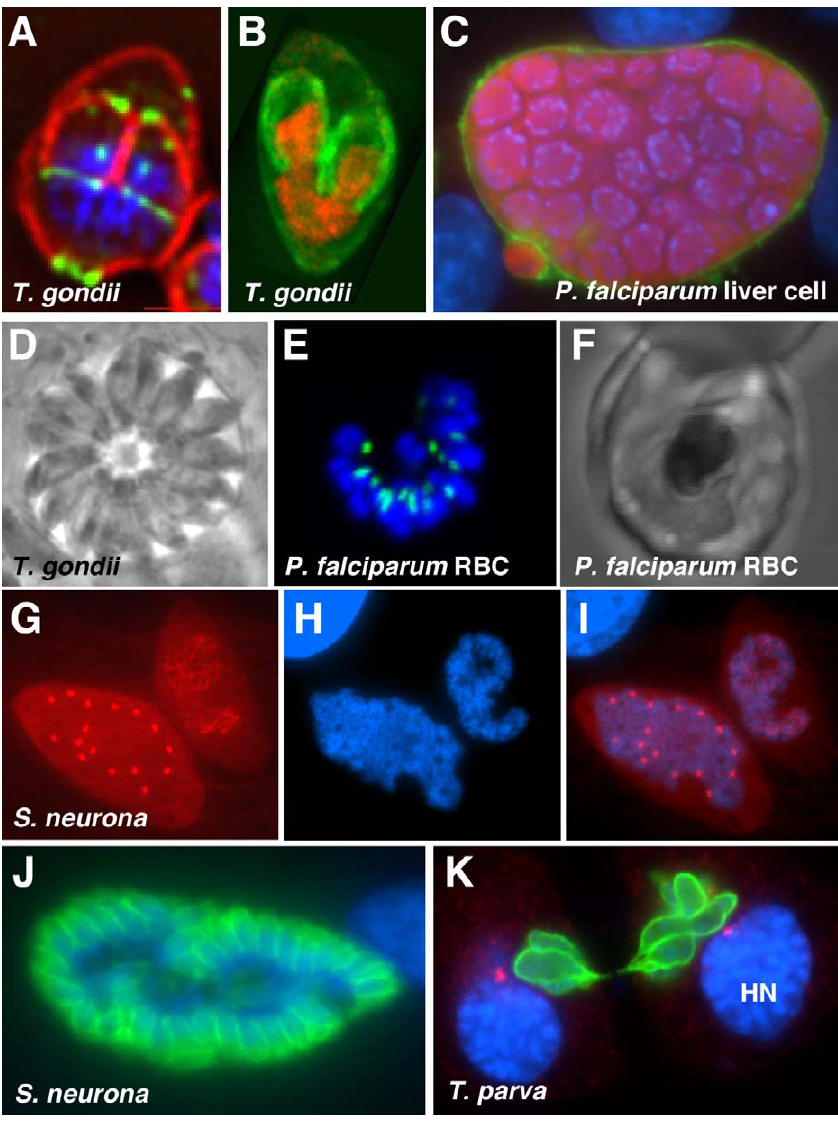
Figure 2. The Diversity of Intracellular Development in Apicomplexans (A) In T. gondii, two daughters are formed during budding. IMC1, red; MORN1, green (reproduced with permission from [32]). (B) T. gondii. Histone H2, red; IMC3, green (reproduced from [71]). (C) In Plasmodium falciparum liver schizont, budding results in massive numbers of zoites. Image courtesy of Volker Heussler. (D) T. gondii, phase contrast image of parasitophorous vacuole harboring multiple tachyzoites. (E and F) P. falciparum late erythrocyte schizont. Acyl carrier protein (plastid), green. RBC, red blood cell. (G–I) Sarcocystis neurona. Two intracellular stages with polyploid nuclei, one in interphase and one during mitosis. Tubulin, red. (J) S. neurona budding. IMC3, green. (K) A Theileria schizont divides in association with its host cell. Polymorphic immunodominant molecule (parasite surface), green; c -tubulin (host centrosomes), red. HN, host nucleus. Image courtesy of Dirk Dobbelaere. The DNA dye DAPI is shown in blue throughout. Not to scale.